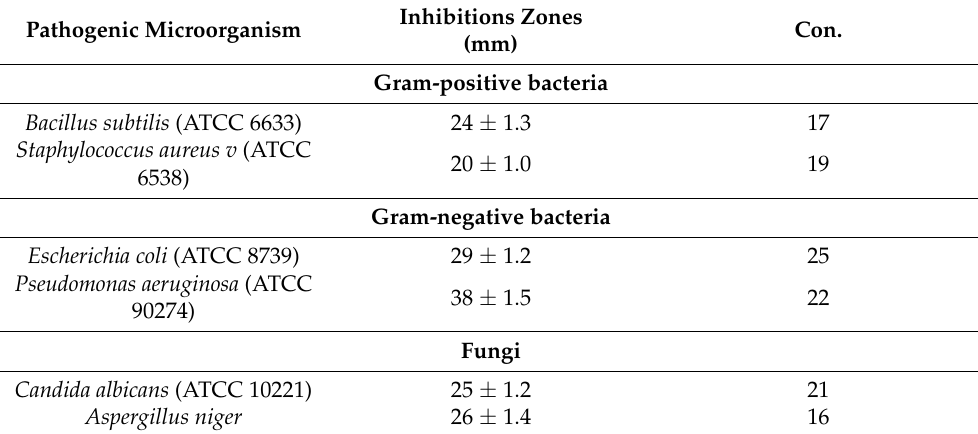
Table 5. Antimicrobial efficiency of purified chitinase by T. funiculosus strain CBS 129594 against Gram-positive bacteria, Gram-negative bacteria, and